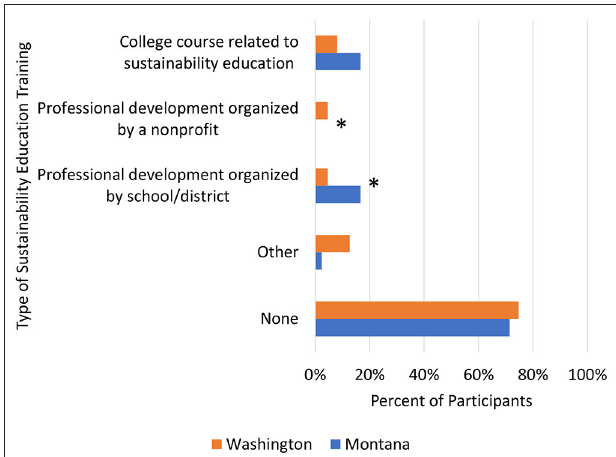
FIGURE 5 | The percent of participants from Washington ( n = 87) and Montana ( n = 84) that report having received each type of training focused on teaching about sustainability. Asterisks represent significant differences.